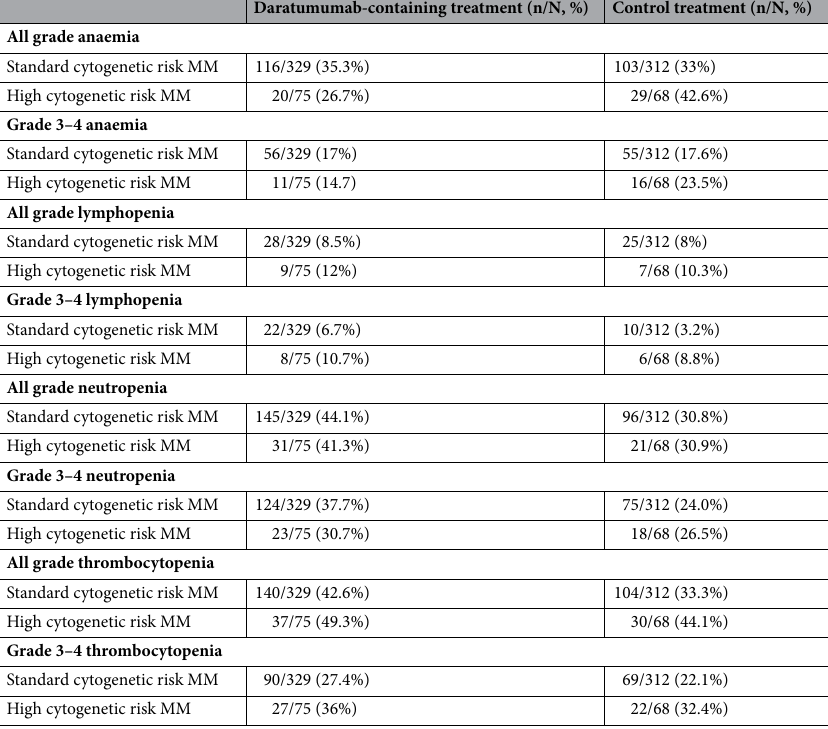
Daratumumab-containing treatment (n/N, %) Control treatment (n/N,